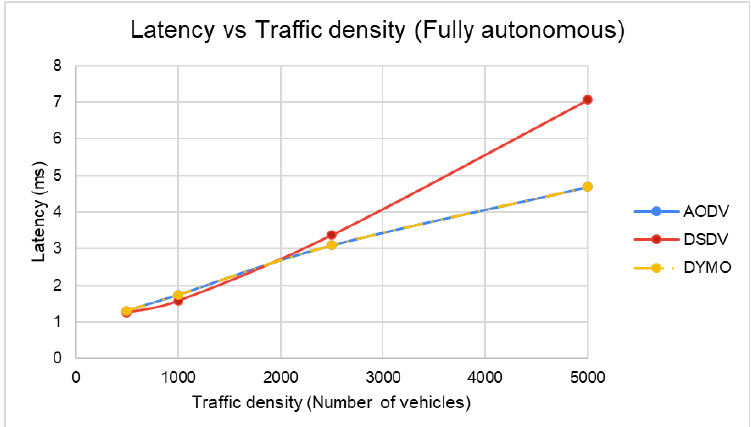
Figure 13. Latency graph for fully autonomous vehicles with varying traffic densities.